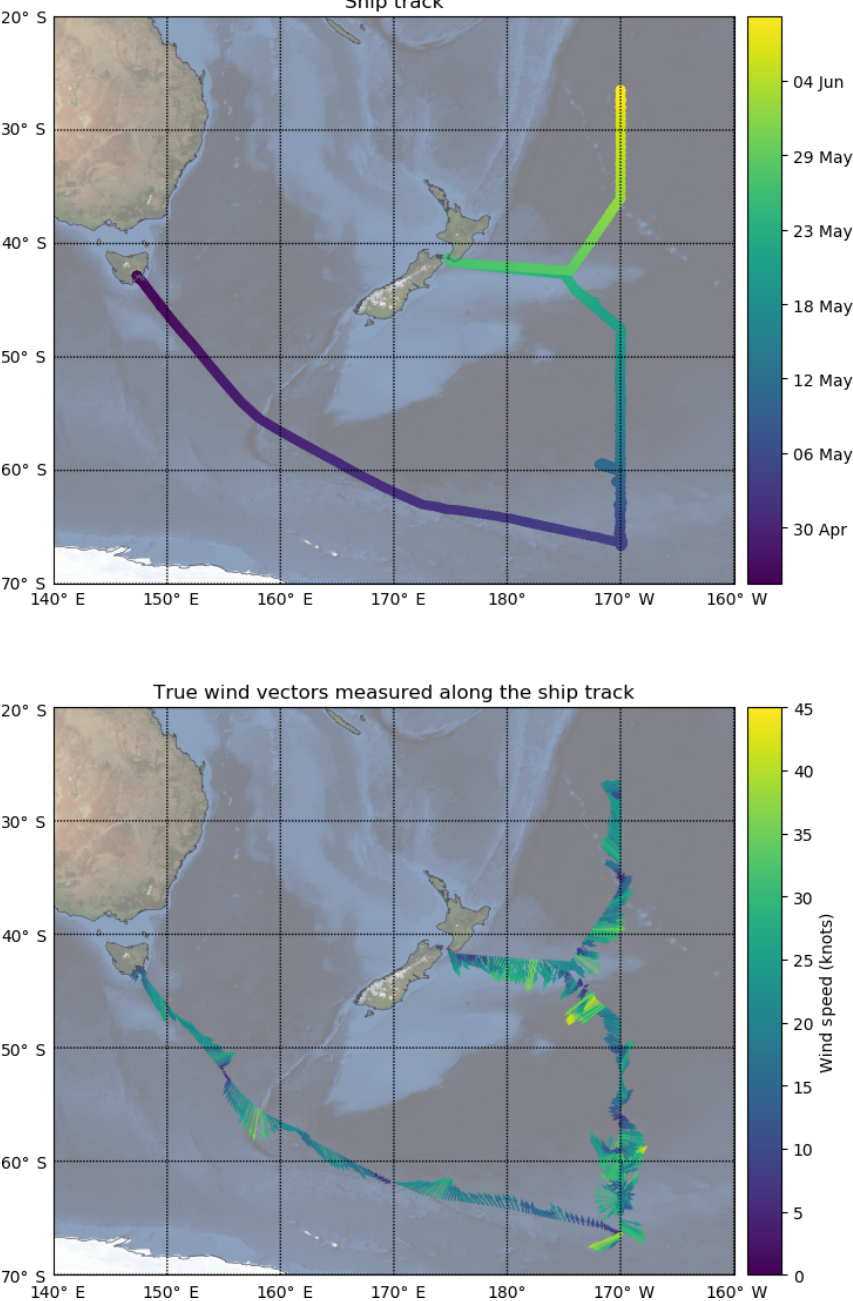
Figure A4. Voyage track of the data utilised in this voyage. Starting in Hobart, Australia, the voyage’s primary goal was to perform ocean sampling along the 170 ◦ W longitudinal line, with a brief personnel changeover in Wellington, New Zealand. This dataset was chosen as it contained clean marine background, as well as periods when it had increasing urban influence (as it travelled towards and arrived in Wellington), enabling fine tuning of the algorithm to only remove platform